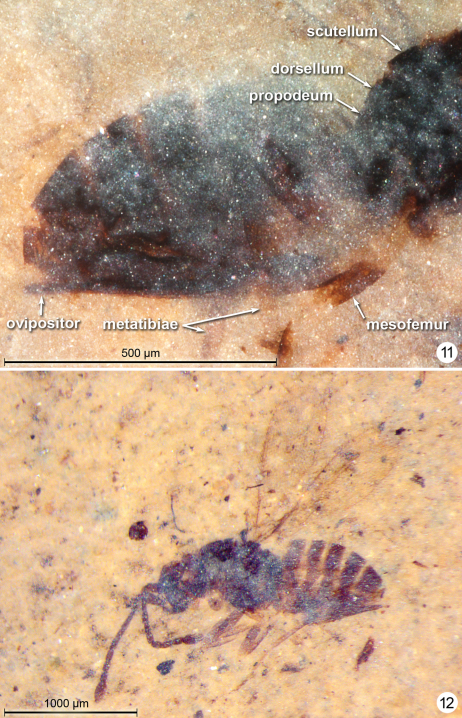
Gonatocerus spp. 11
Gonatocerus kootenai holotype, posterior half of mesosoma and metasoma 12
Gonatocerus rasnitsyni holotype, habitus lateral.